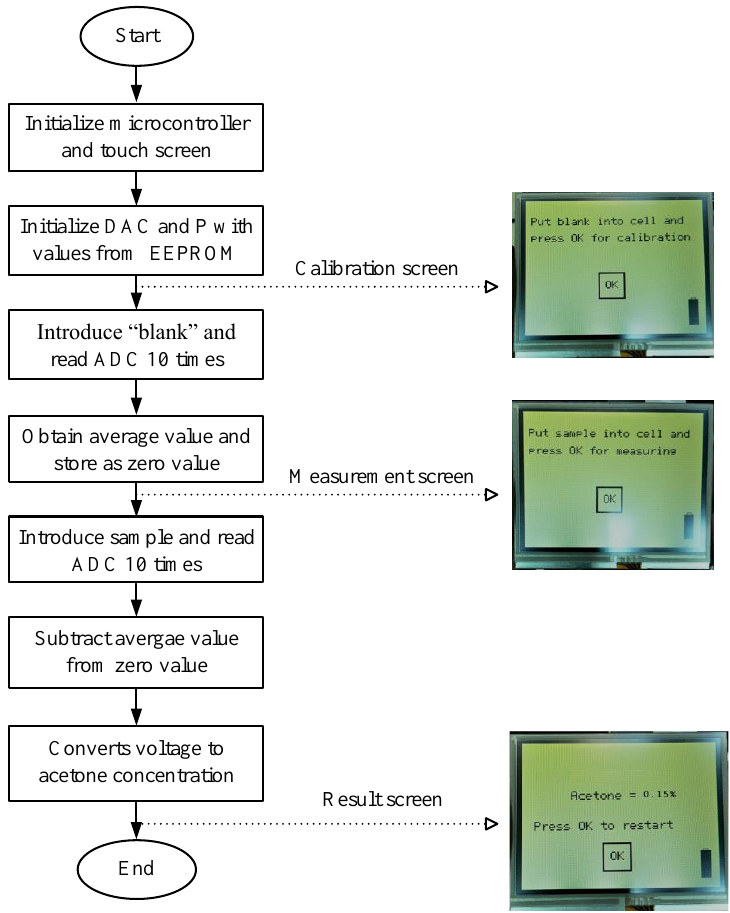
Figure 5. Microcontroller flowchart and the user interface screens (ADC: analog-to-digital coverter, DAC: digital-to-analog converter, EEPROM: Electrically Erasable Programmable Read-Only Memory; P: Potentiometer).